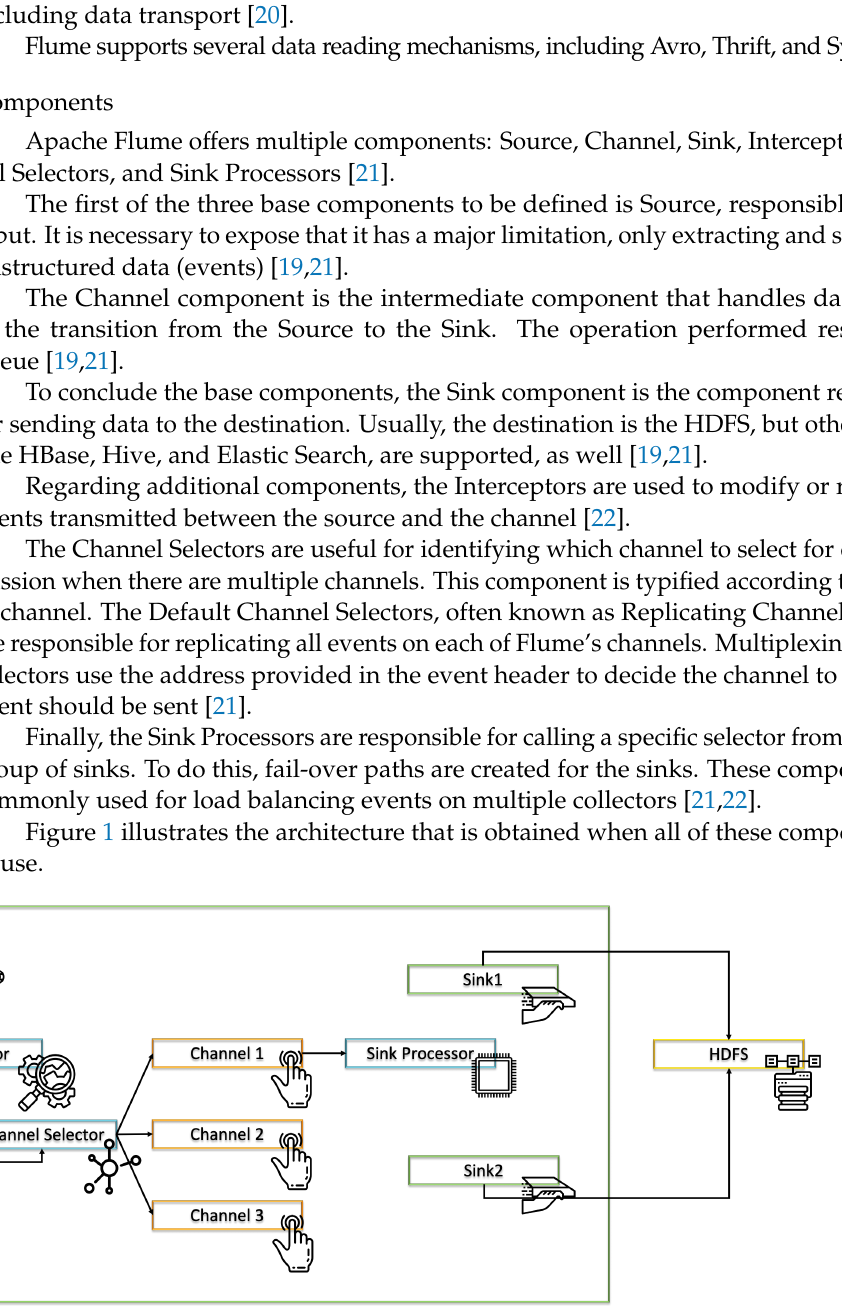
Figure 1. Flume architecture. Adapted from Reference